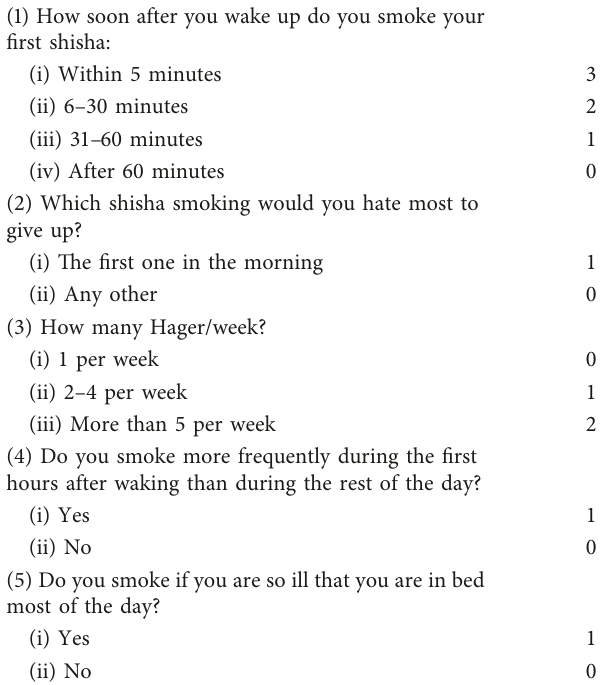
Table 6: Prevalence rate of ever smoked shisha stratified by grade and sex.